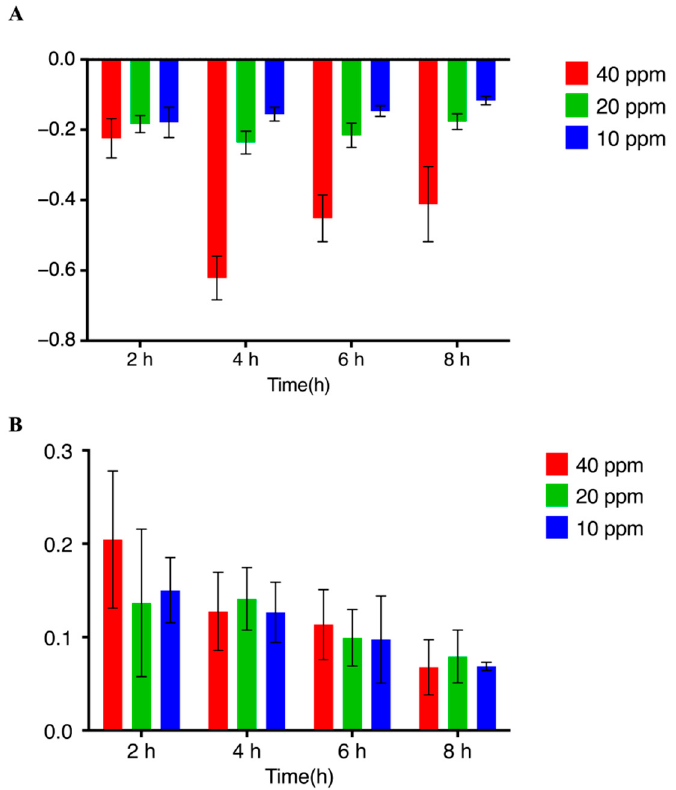
Figure 8. Results of the nematode chemotaxis assay. ( A ) Avoidance activity of 8 at different times and concentrations. ( B ) Attractive activity of 9 at different times and